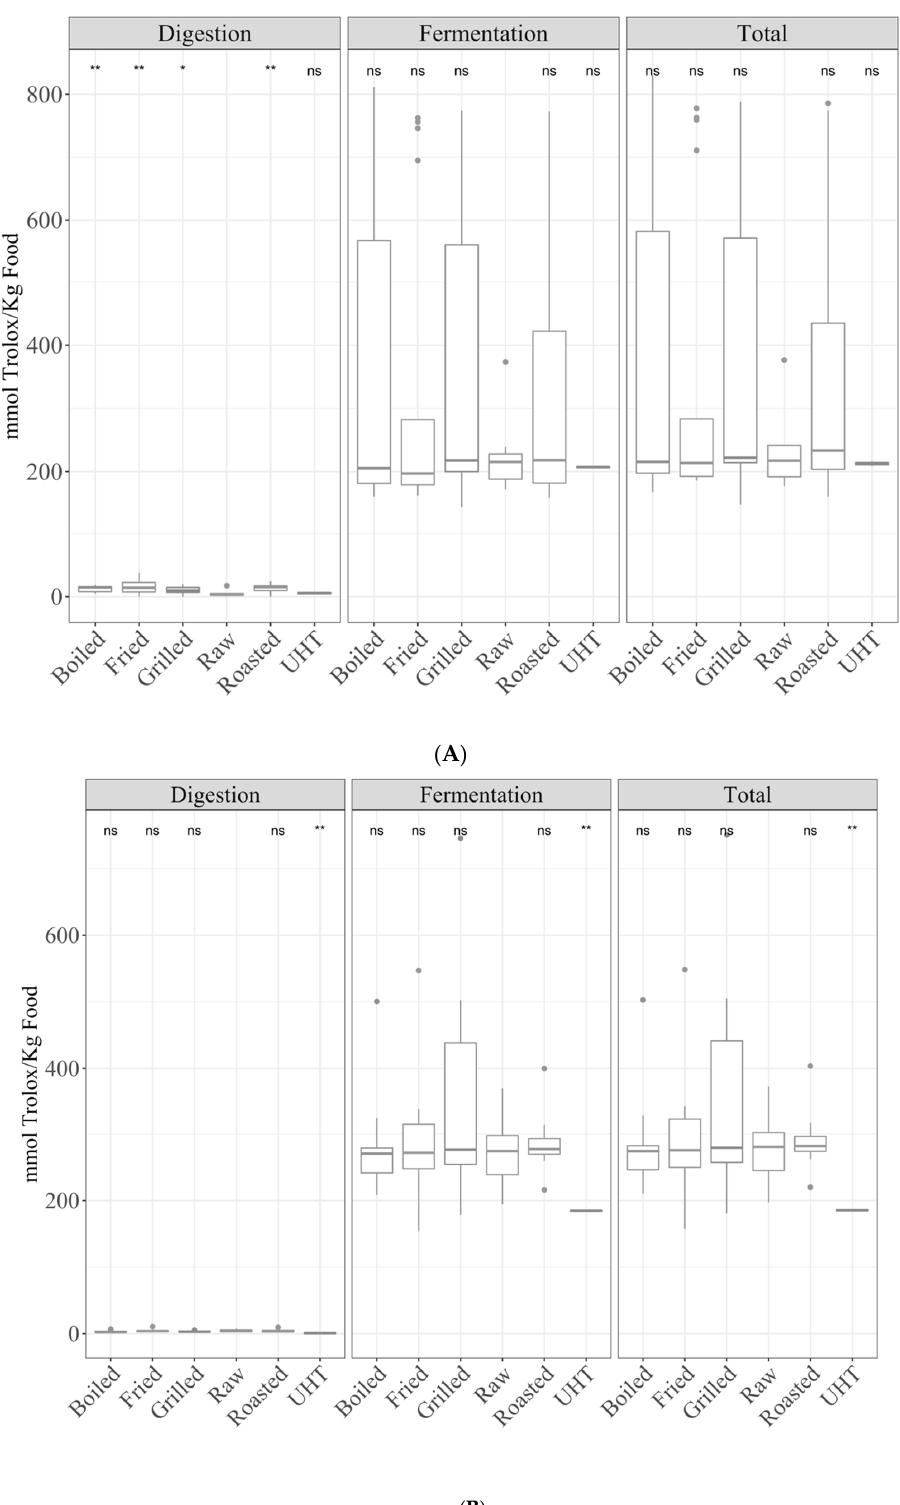
Figure 1. Antioxidant capacity of food of animal origin (butter, cheese, milk, yogurt, egg, cod fish, salmon, beef, chicken, lamb, and pork) obtained after in vitro digestion and fermentation, depending on the cooking technique (( A ) Trolox capacity against DPPH radicals (TEAC DPPH ), ( B ) for Trolox equivalent antioxidant capacity referred to reducing capacity (TEAC FRAP )). Statistical analysis was performed through ANOVA using raw foods as the reference group. Statistic labels: *: p < 0.05, **: p < 0.01, ns: not